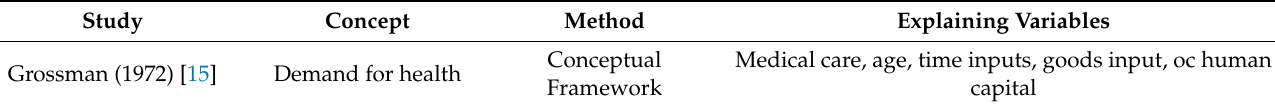
Table 1. Studies for unmet medical